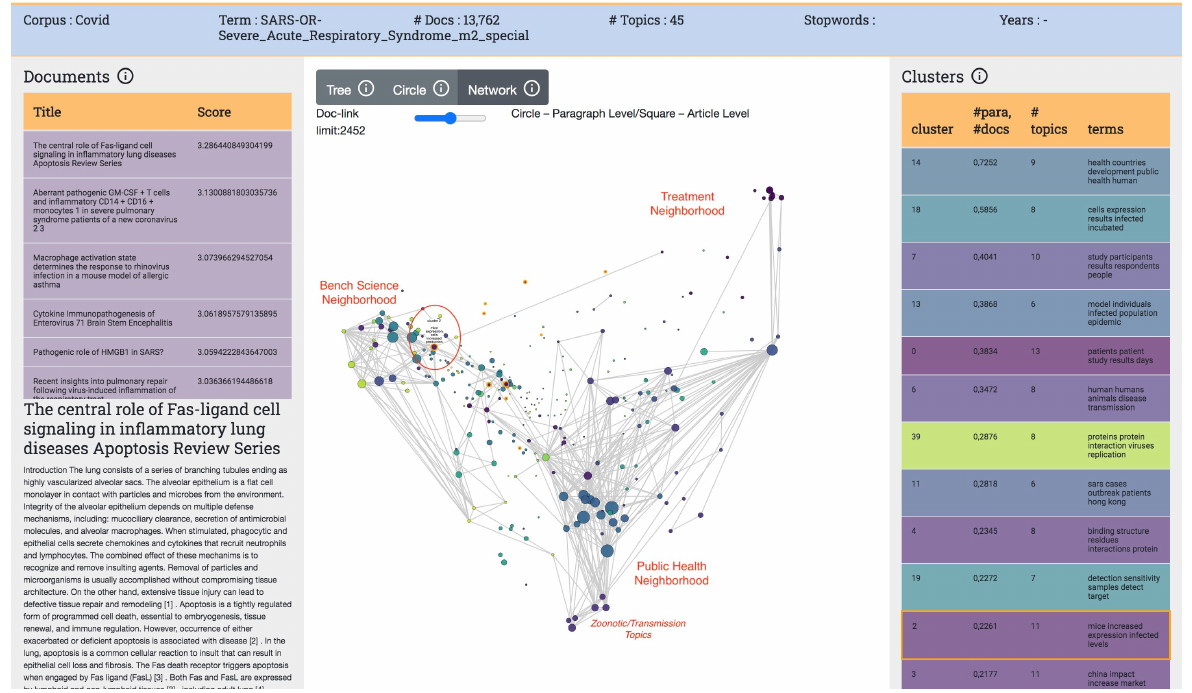
Figure 3. Network visualization of the SARS Topic Model excluding COVID-19